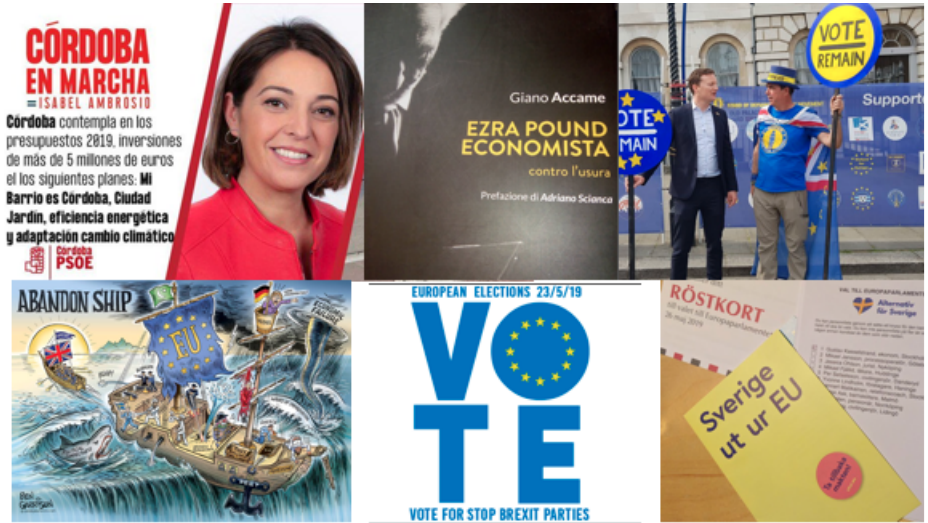
Figure 2. Examples of modal categories. Note: From top left to bottom right, examples of ‘official campaign communica- tion,’ ‘other political,’ ‘citizen political activism,’ ‘political humor,’ ‘satellite campaigning’ and ‘voting